Question: Identify the chart type used in this figure.
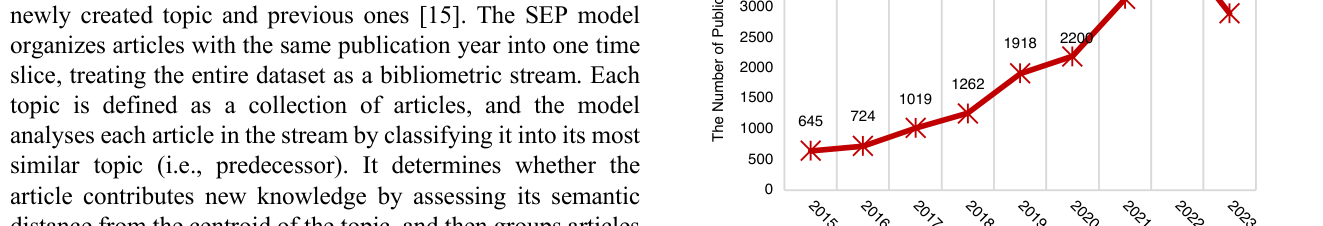
Answer: line